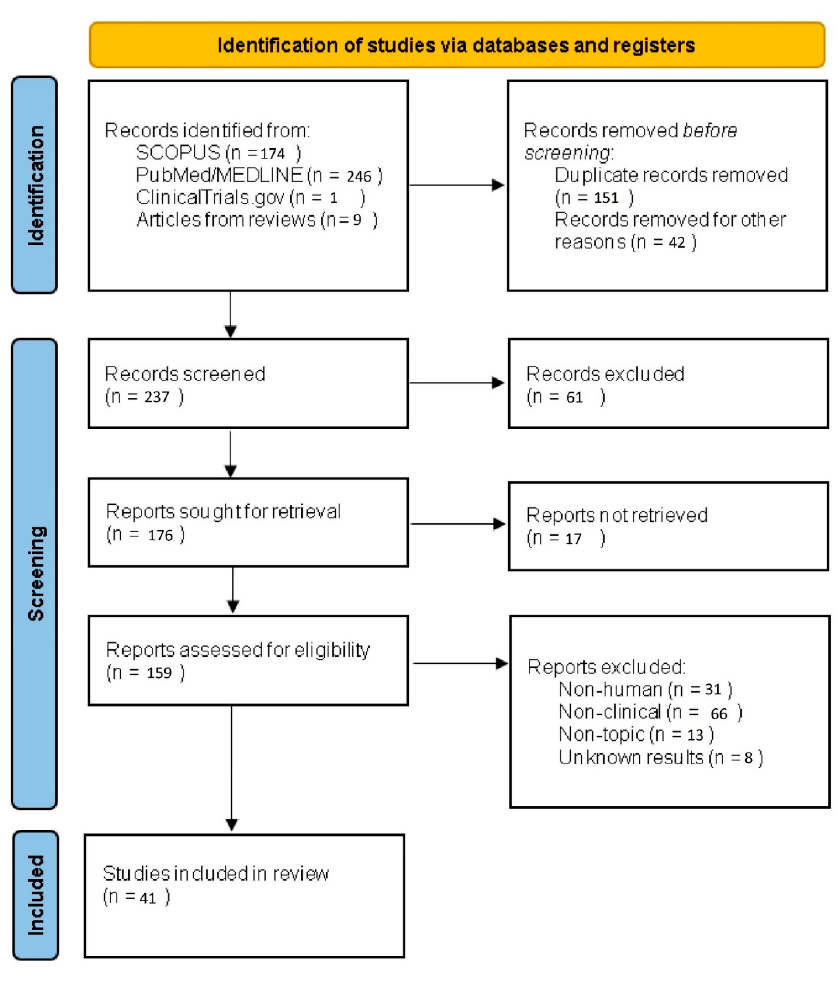
Figure 1. PRISMA flow diagram depicting the process of the literature search. The study was registered in PROSPERO: the registration number is